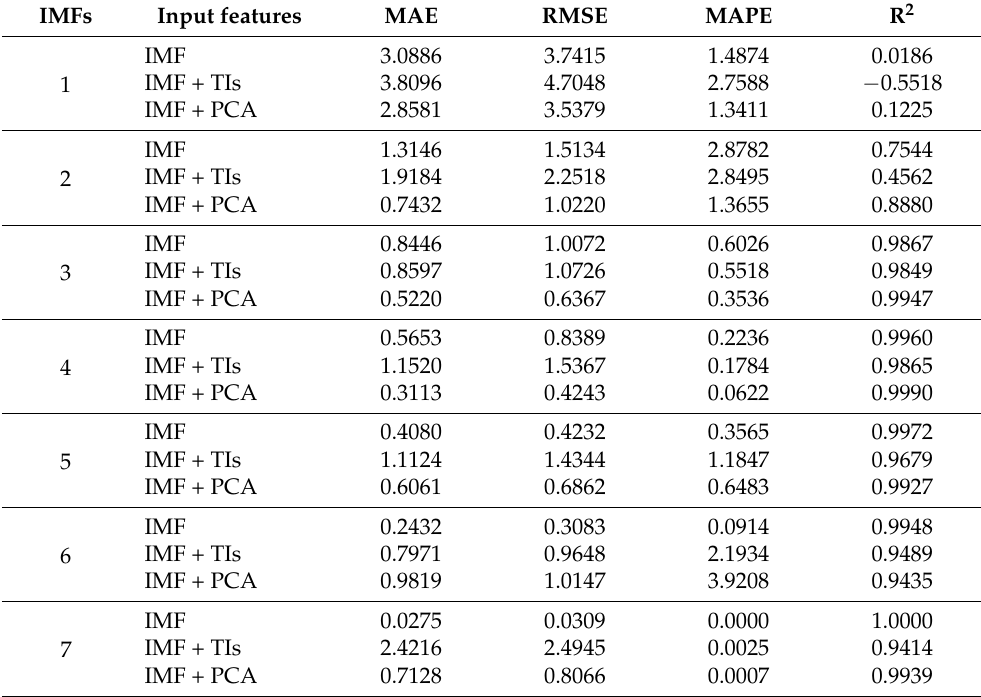
Table 7. Results of IMFs prediction from EMD-LSTM with additional input feature.